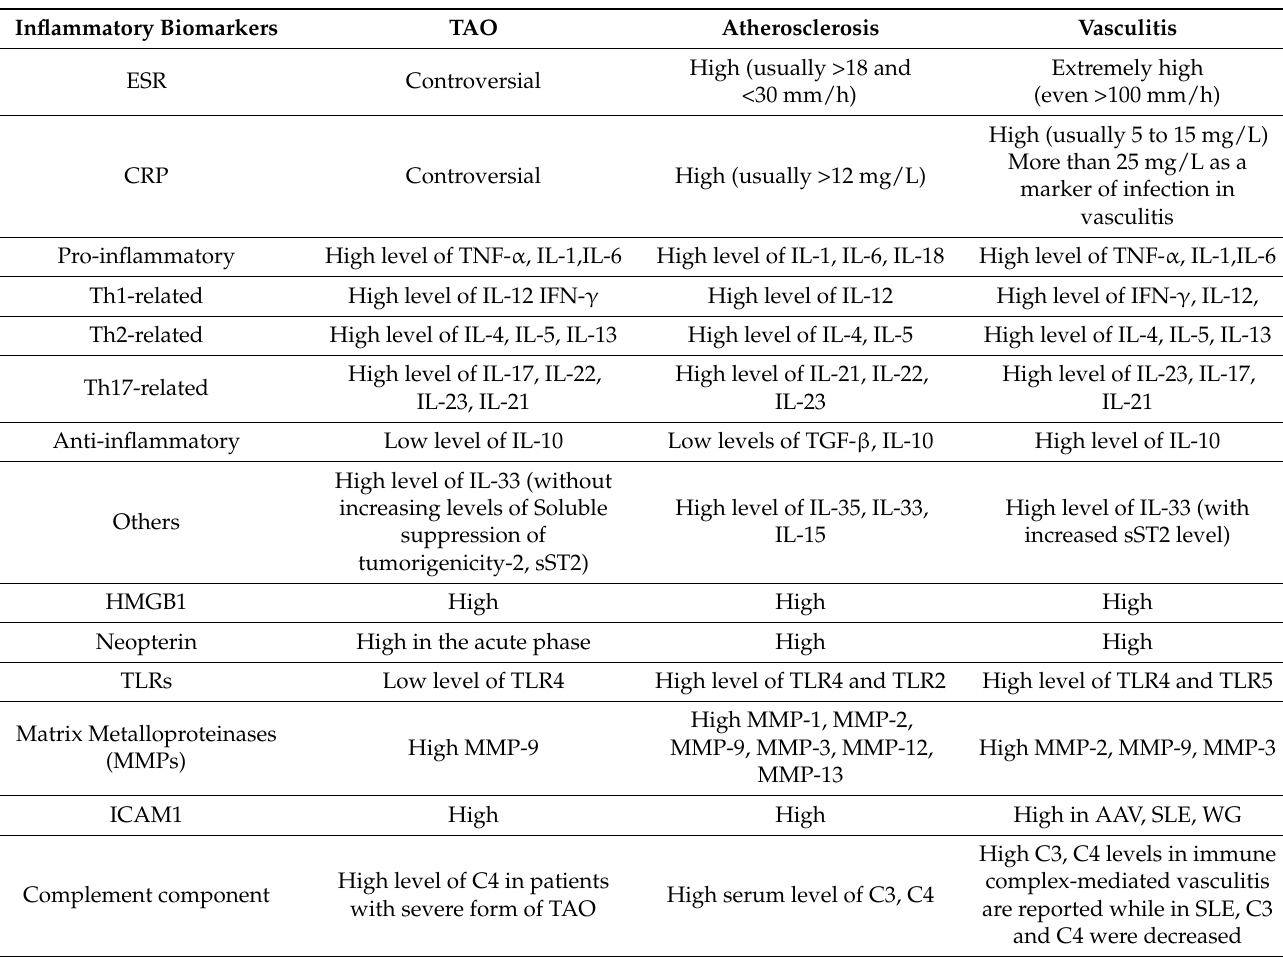
Table 3. Summary of the main findings on inflammatory